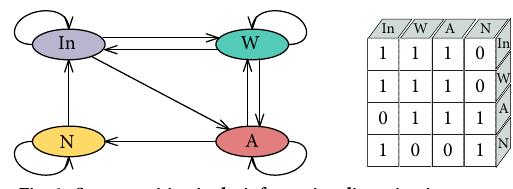
Fig. 6 State transition in the information dissemination